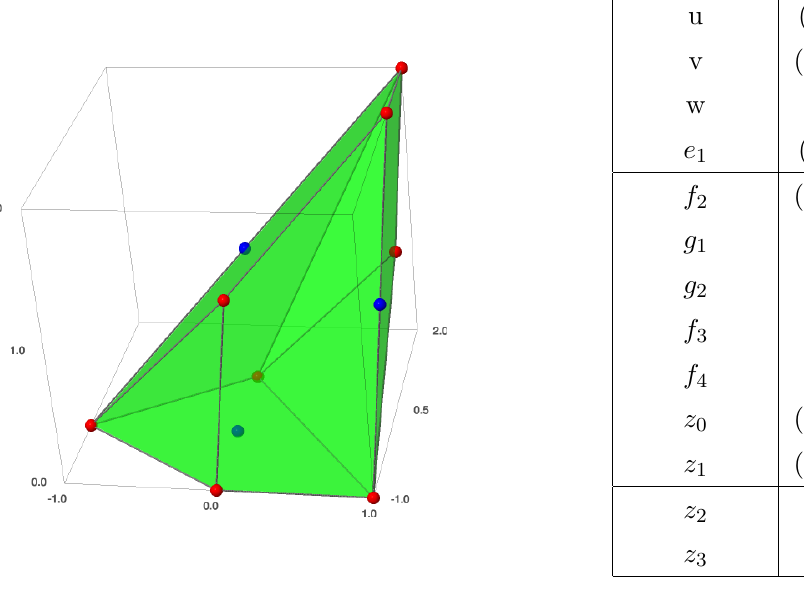
Figure 13 . The polytope formed by F 3 and an SO(10) top with vertices listed in the table. The polygon F 3 is visible at height 0; four SO(10) vertices appear at height 1 and the other two at height 2. The vertices corresponding to z 1 and the coordinates z 2 , z 3 of the second P 1 are not shown in the